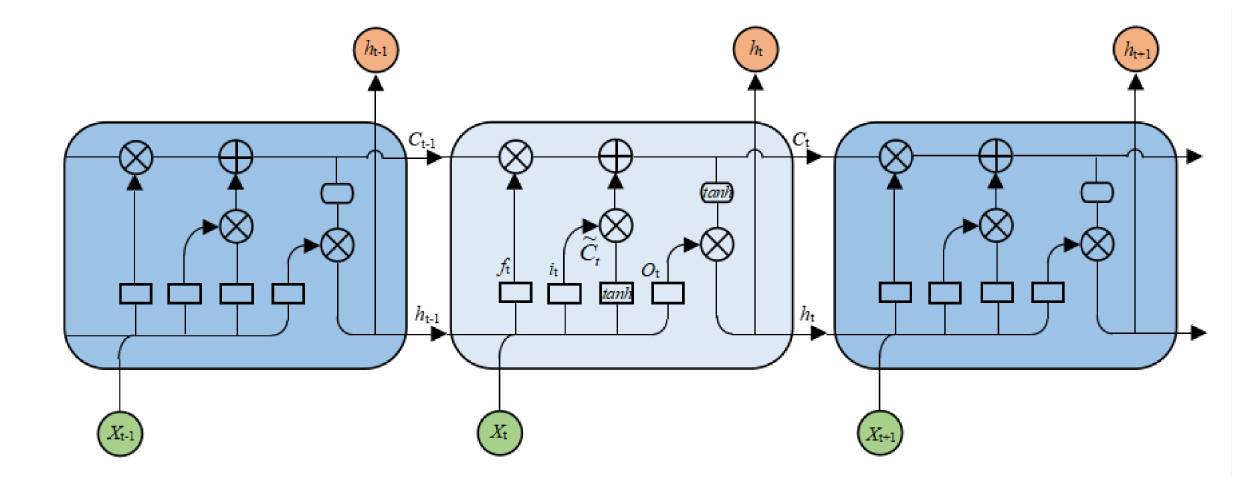
Figure 3. Structure of the LSTM neural